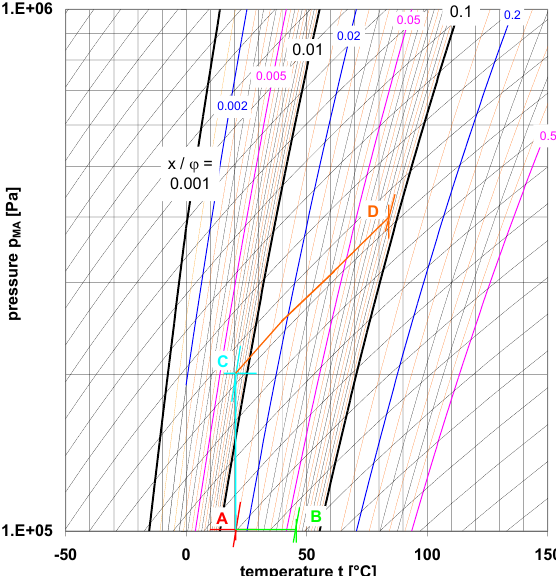
Fig. 5. The method of reading of the properties of moist air in the equilibrium p - t diagram of moist air with curves of constant ratio of specific and relative moisture  / x